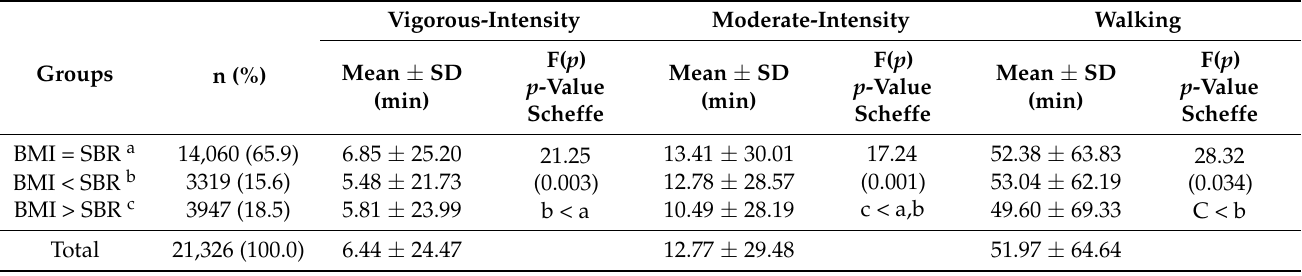
Table 2. Comparison of vigorous-intensity activities time, moderate-intensity activities time, and walking time according to difference between BMI and subjective body